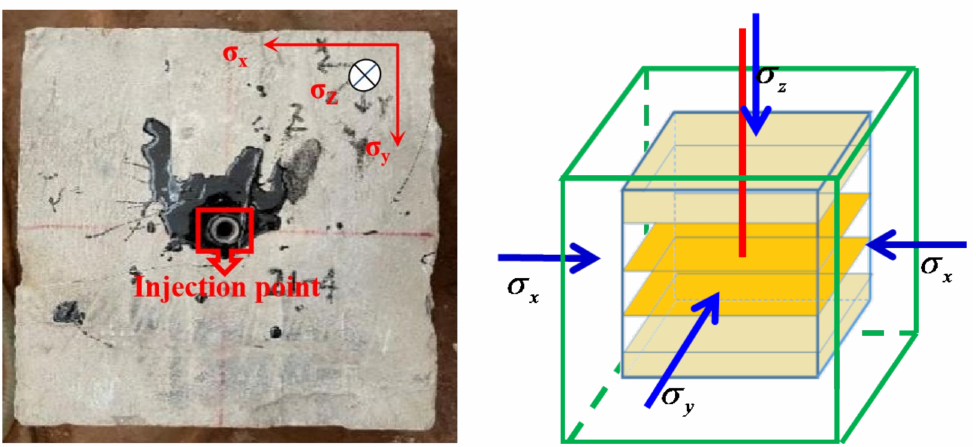
Figure 9. Loading